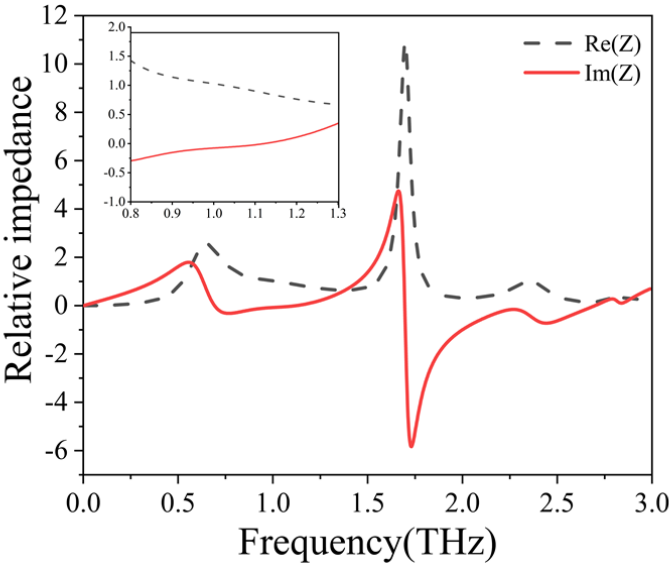
Figure 7. The equivalent relative impedance of the proposed metamaterial. To further analyze the absorption and transmission mechanism of the proposed multi- functional graphene tunable metamaterial, we simulated the current distribution and the electric field distribution at three key frequency points, as shown in Figure 8. These three frequency points are 0.72 THz, 1.26 THz and 2.35 THz, representing two absorption fre- quency points and one transmission frequency point, respectively. We use color to represent electric field strength and current strength, red for strong electric field and current, blue for weak electric field and current. At 0.72 THz, the graphene structure of the metamaterial unit produces strong electric and magnetic resonance. It should be mentioned that the magnetic resonance is produced by the interaction of the graphene layer and the metal layer on the FSS. Under the action of terahertz radiation, both the top graphene structure and the metal layer of the frequency selective surface will generate induced current, which are in opposite directions and parallel to each other. At this time, it can be seen that magnetic dipoles with opposite directions and parallel to each other are generated. When the magnetic resonance of the magnetic dipoles is the strongest, it will consume a lot of terahertz energy and realize strong absorption. Similarly, at 1.26 THz, the edge of the graphene ring generates strong electric resonance, which is due to the resonators formed between the graphene structures of adjacent cells. The strong electric resonance combined with magnetic resonance also produces strong absorption. In addition, it can be seen that the magnetic resonance of graphene-based metamaterial is very weak at 2.35 THz, so the absorption rate is low at this frequency. However, at 2.35 THz, the layer where the frequency selective surface is located produces a strong electric field intensity, which indicates that the frequency is just in the transmission band, forming a transmission